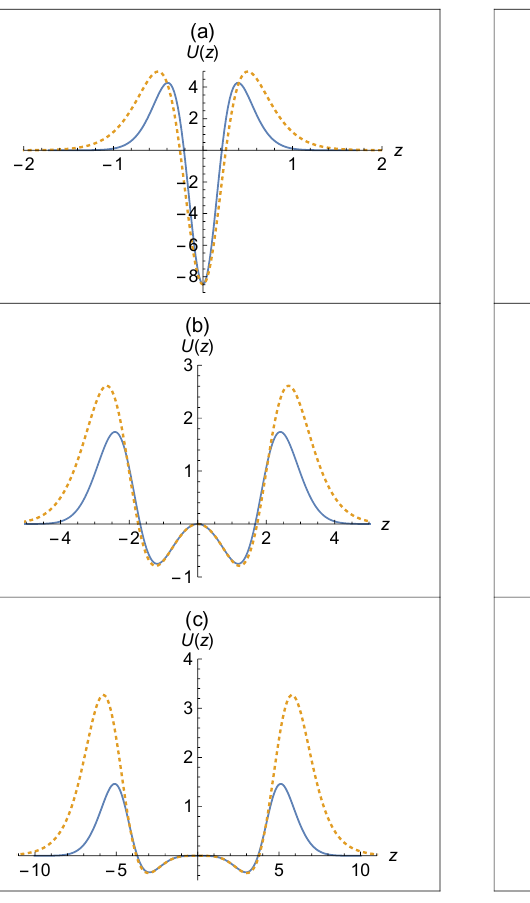
Figure 3 . Potentials U ( z ) and Transmission coe(cid:14)cient T ( m 2 ) for massive left fermions (odd dimensions) and Dirac fermions (even dimensions choosing (cid:24) n (cid:0) ( x )) with (cid:21) = 0 ; 4 for D = 5 (line) and D = 10 (dotted), with (cid:17) = 1 and s = 1 (a, d), s = 3 (b, e) and s = 5 (c,